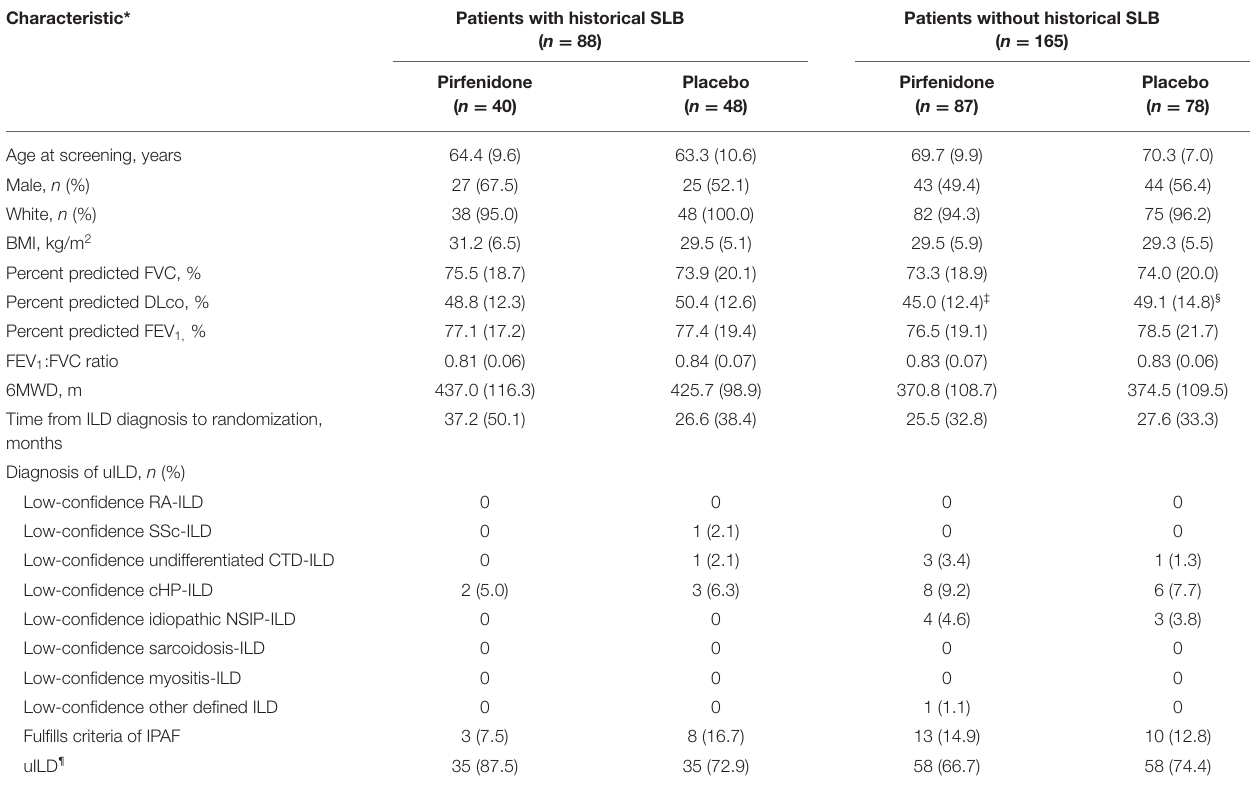
TABLE 1 | Demographics and baseline characteristics of patients in the pirfenidone in uILD study analyzed by SLB status.